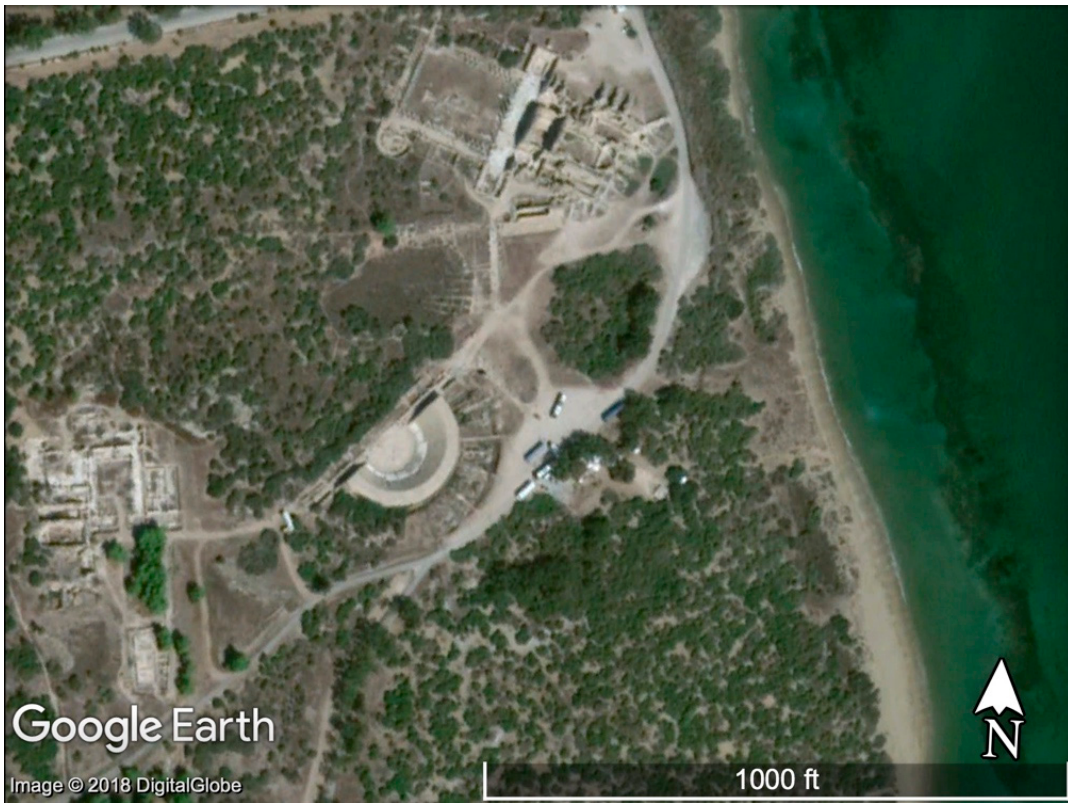
Figure 6. Aerial view of the modern ruins of Roman Salamis showing the location of the theater, gymnasium, and baths. Note the reefs visible in the sea to the east. Source: Google Earth; Map Data: Google, Digital Globe.